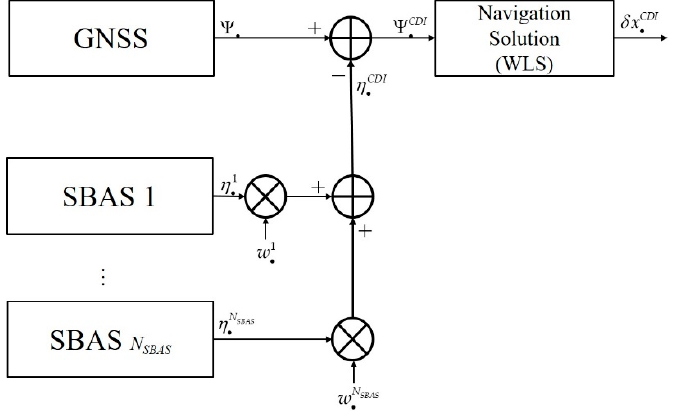
Figure 2. Correction domain integration (CDI) for single global navigation satellite system(GNSS) augmented with multi-SBAS.